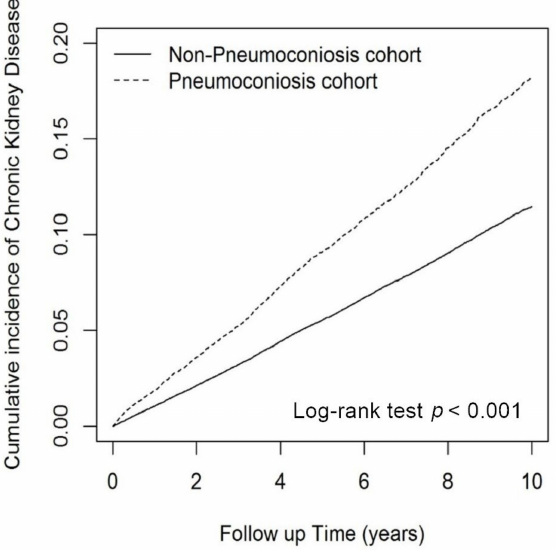
Figure 2. Cumulative incidence of chronic kidney disease in the pneumoconiosis and the nonpneu- moconiosis